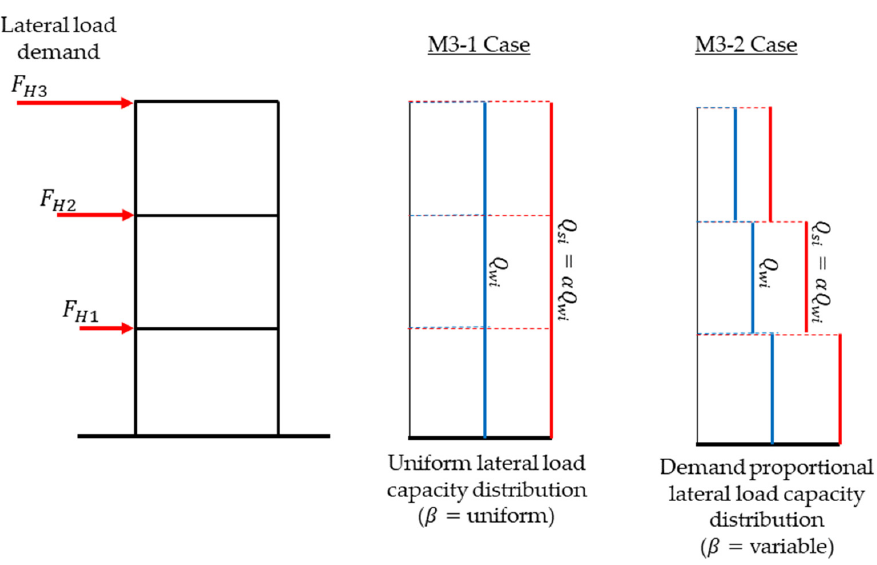
Figure 5. Lateral load capacity distribution scenarios for the M3 model.